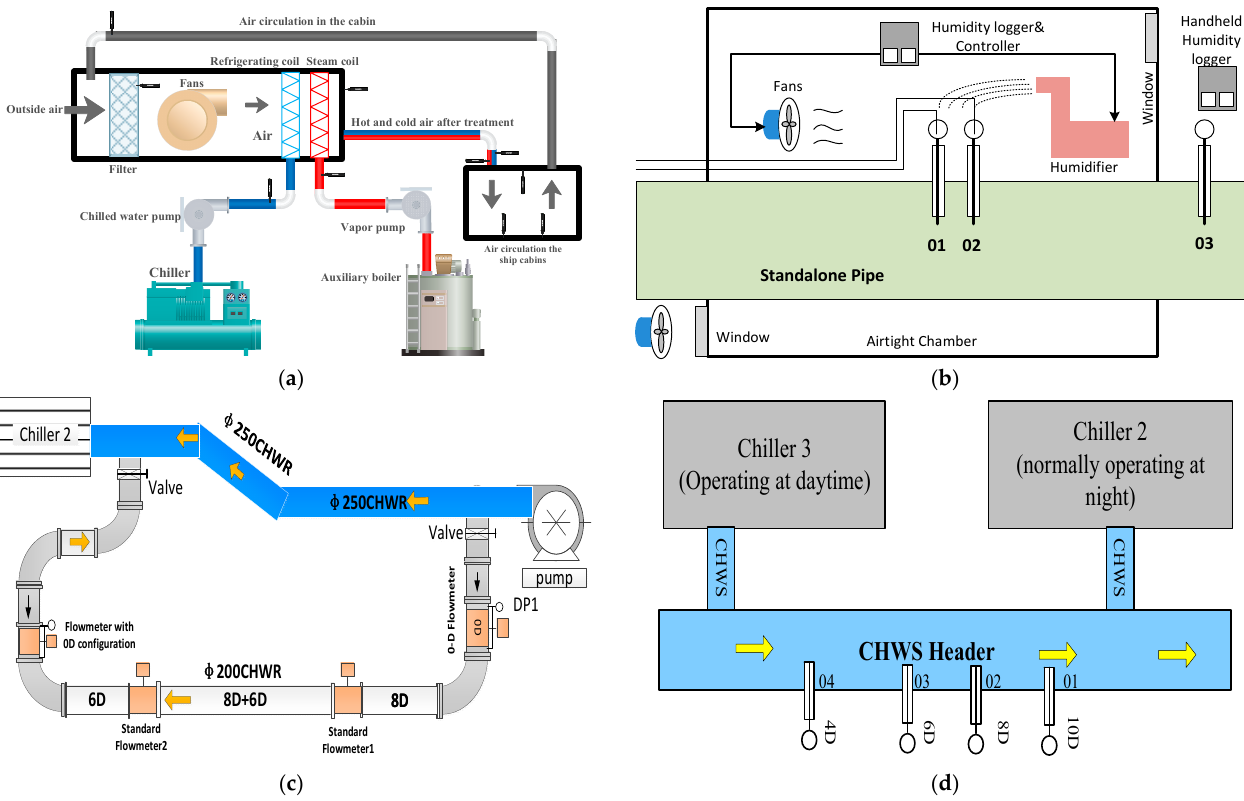
Figure 4. Experimental setup of FBG temperature sensors in marine chiller and pipeline system: ( a ) principle of ship ventilation and air conditioning chiller system; ( b ) influence of humidity and condensation temperature on FBG sensor under maritime conditions; ( c ) specific form of the temperature test for the bypass pipeline of chiller unit; ( d ) influence of the mixing end of the chiller cold-water supply on the FBG temperature reading accuracy.